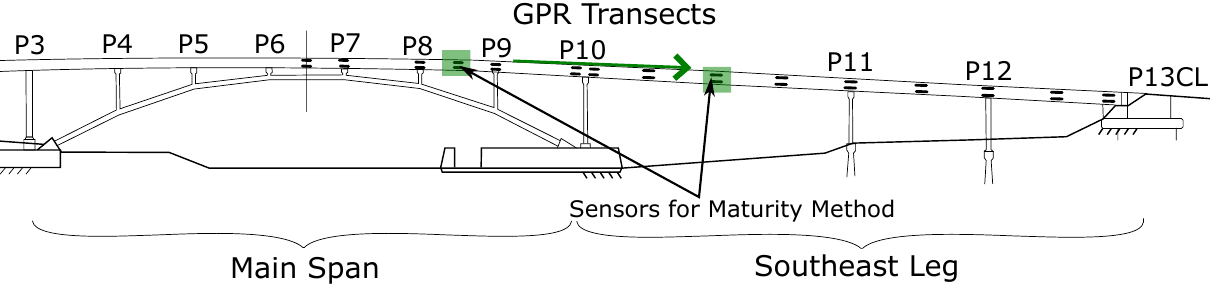
Figure 4. Elevation view of the Streicker bridge with sensor locations and direction of GPR transects.